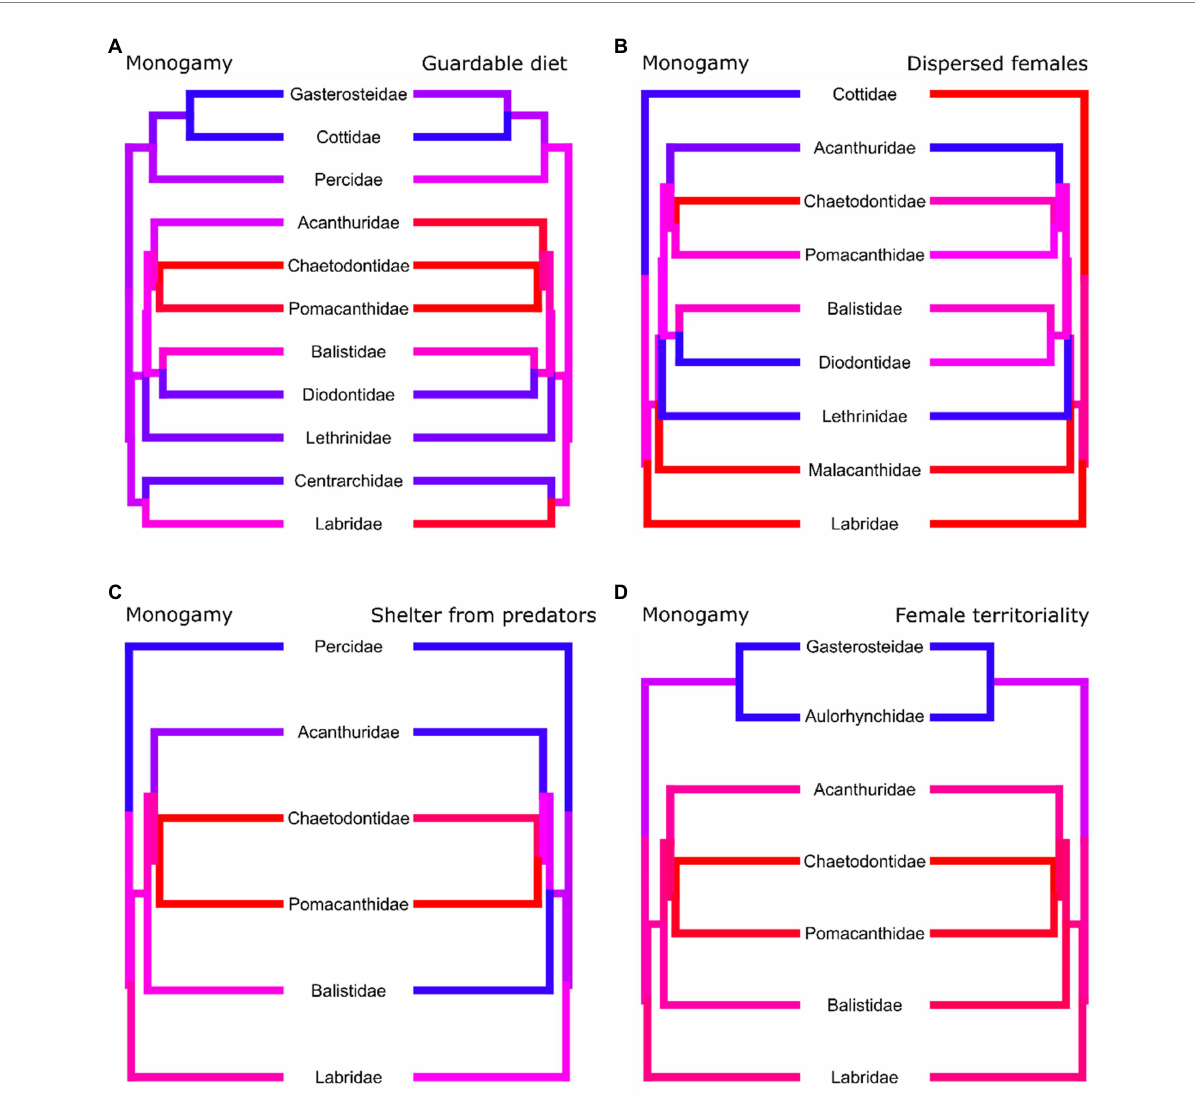
FIGURE 4 Phylogenetic trees where each tip corresponds to a genus of marine reef fishes. Tip and branch colours correspond to the proportion of species with data present in the genus which display the trait, with red corresponding to a value of 1 and blue to a value of zero. For each tree we only included species which had data present for both traits and not all trees contain the same genera. Although all paired traits evolve dependently with each other, the coincidence of monogamy and its paired trait differs. (A) Monogamy is more prevalent in genera with diets of guardable food. Highly monogamous genera are more likely to also have a high incidence of (B) dispersed females and (C) sheltering from predators and vice versa. (D) Genera with a high incidence of monogamy also have a high incidence of female